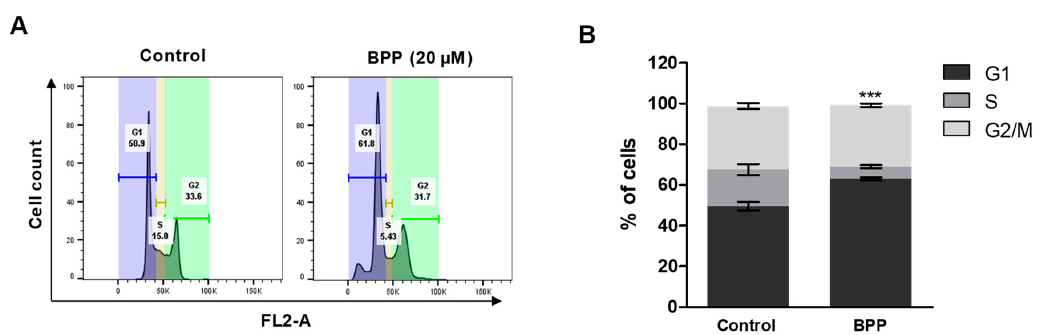
Figure 3. BPP-induced changes in RKO cell cycle progression. ( A ) Cell cycle analysis of compound-treated cells. Cells were stained with PI (propidium iodide) for 30 min and analyzed by flow cytometry. ( B ) Percentage G1 or S, G2/M phase cells from triplicate experiments were determined.